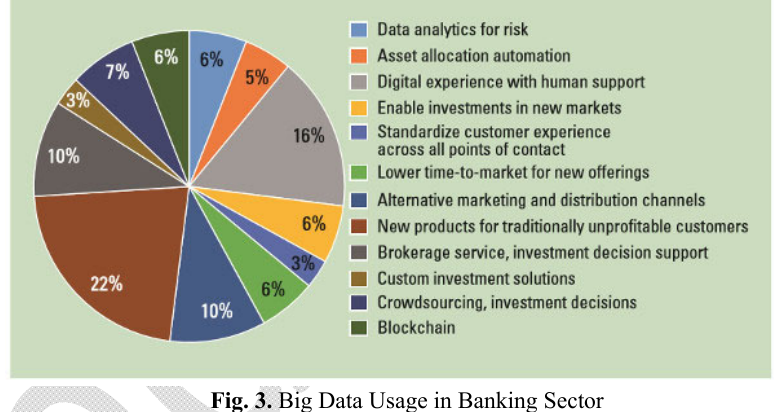
Fig. 3. Big Data Usage in Banking